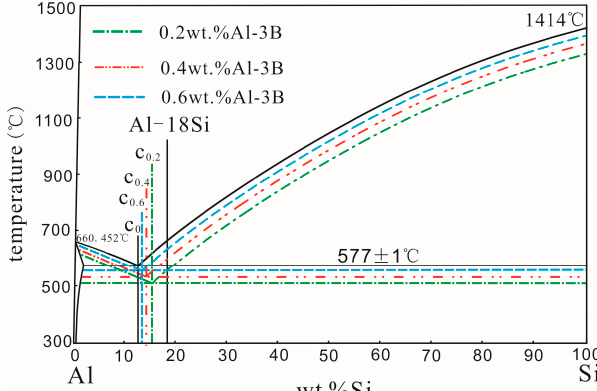
Figure 4. Schematic of eutectic point variation of an Al–Si alloy modified with a higher amount of Al–3B.